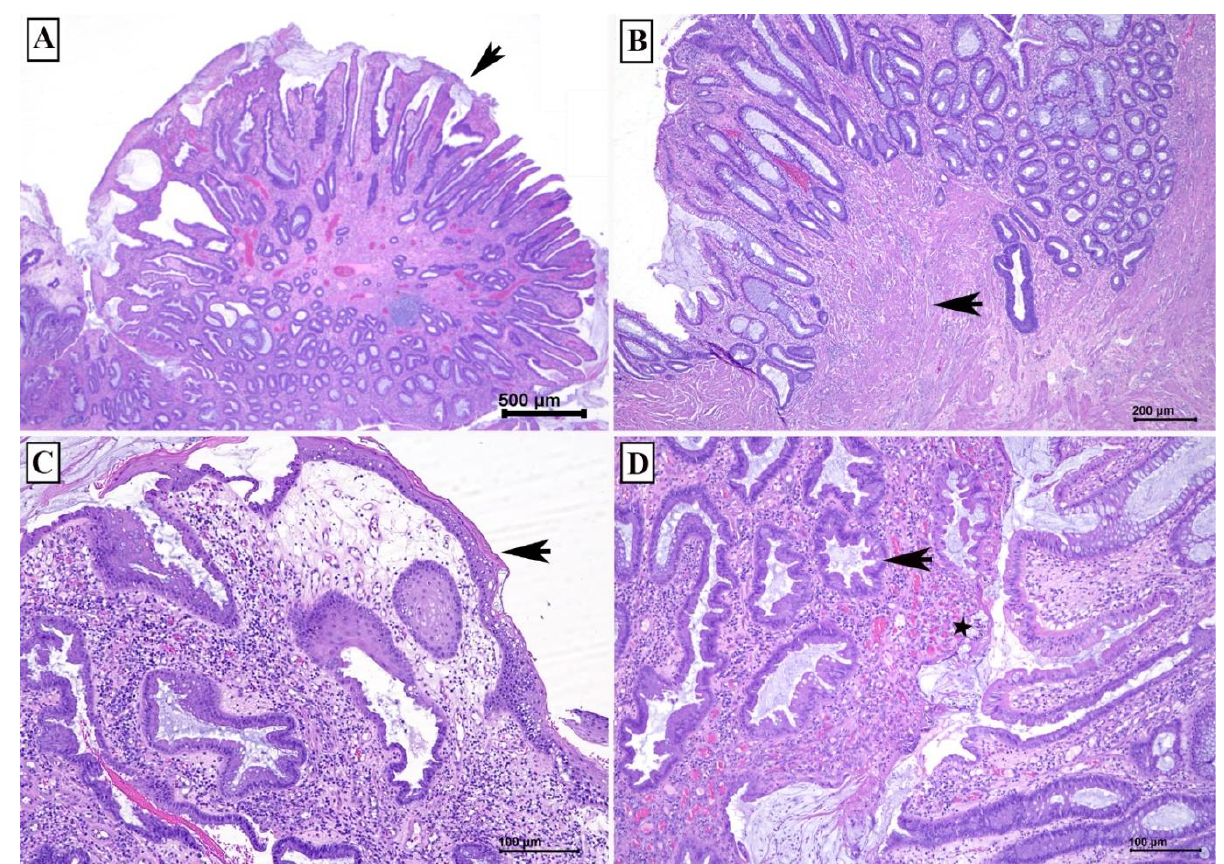
Figure 2. Classic histological features of mucosal prolapse syndrome. ( A ) Polyp demonstrating villiform surface and covered by exudate (arrow) (H&E, scale bar 500 µm). ( B ) Thickened and splayed muscularis mucosa (arrow) (H&E, scale bar 200 µm). ( C ) Focal area covered by squamous epithelium (arrow) (H&E, scale bar 100 µm). ( D ) The glands demonstrate intraluminal serration (arrow) with presence of granulation tissue (star) (H&E, scale bar 100 µm).